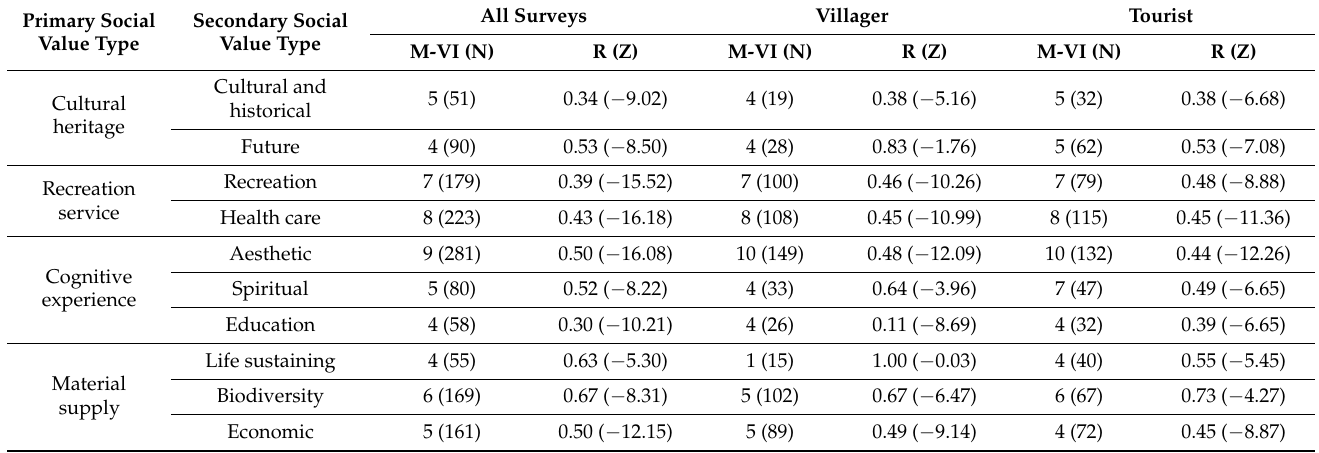
Table 3. The maximum value index (M-VI) and spatial agglomeration of social value types in the Paifang rural community.